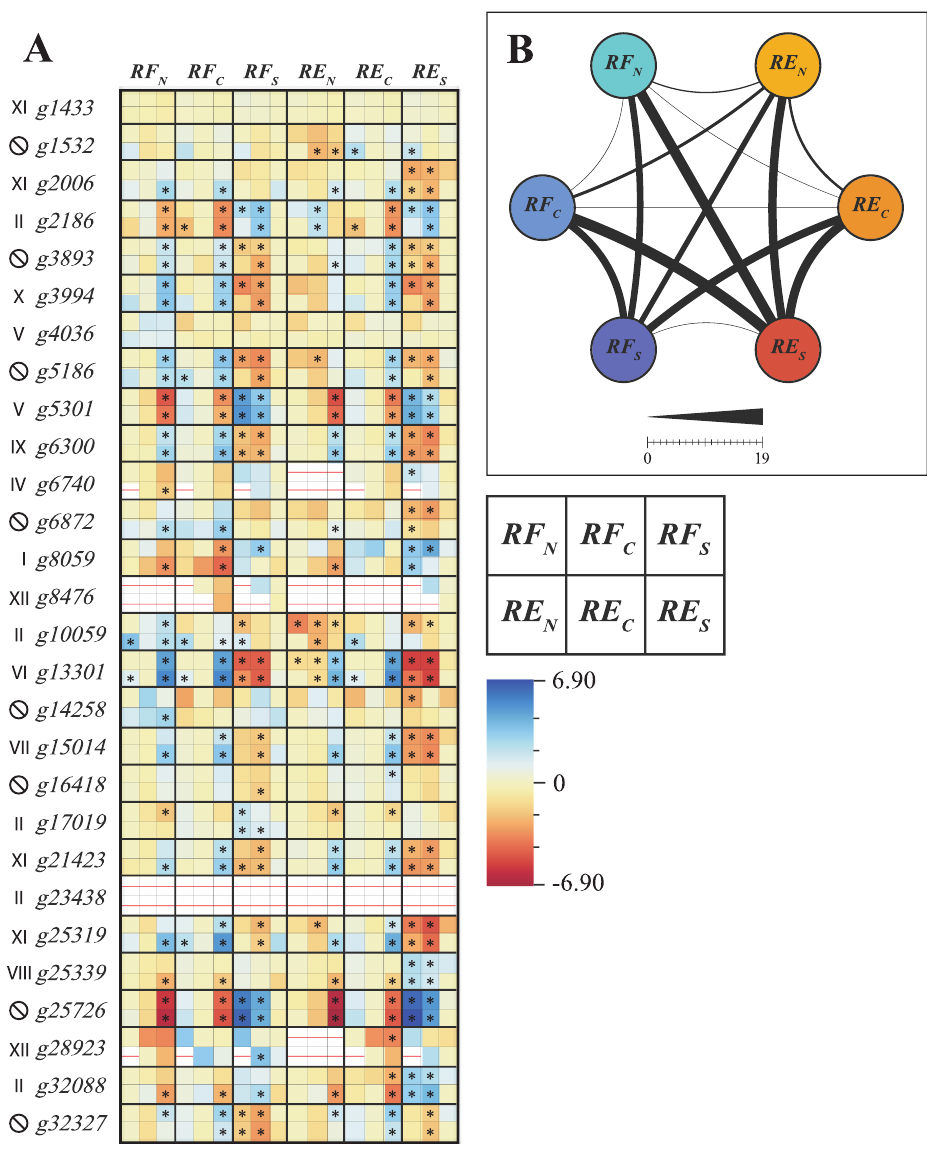
Figure 6. Differential gene expression analysis of Eugenia uniflora DOF genes. ( A ) Each gene phylogenetic groups is indicated on its left. Ungrouped genes are indicated by a crossed-out “O”. Asterisks represent statistically significant FCs, while red lines represent no expression. Each column refers to a sample condition: Riparian Forest in natura (RF N ), RF Control (RF C ), RF Stressed (RF S ), Restinga (RE) N , RE C , and RE S . Each gene has six comparisons on every column, exemplified by the scheme over the FC color gradient. ( B ) DEGs comparison amongst every condition. Thicker lines represent more